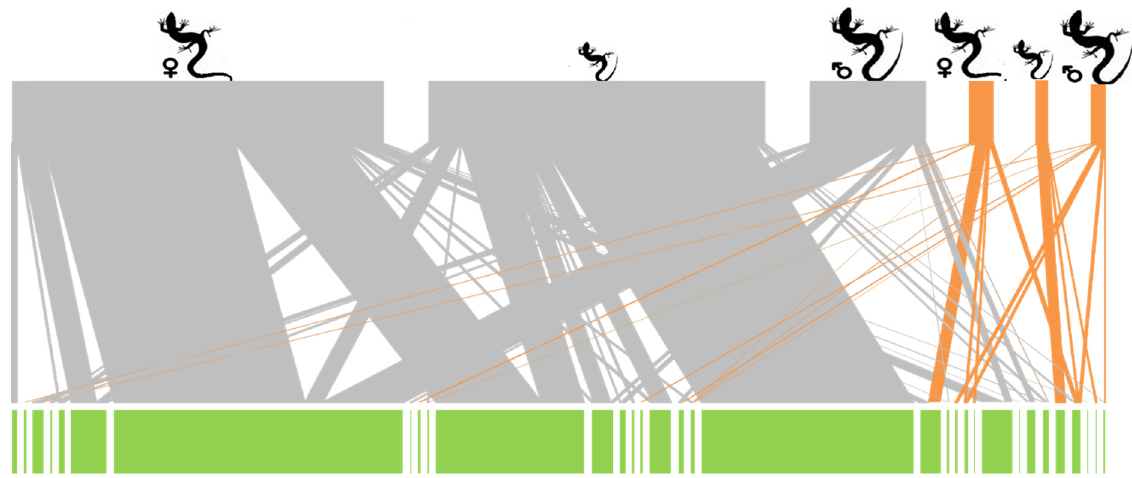
Figure 2. Interactions with flowers per lizard group observed from 5 April to 6 May 2022 on Cabrera Gran (Balearic Islands). Plant species are represented as green nodes, while lizards that visit the flower legitimately are grey nodes and those acting as florivores are orange nodes. Width of edges are proportional to the interaction rate.